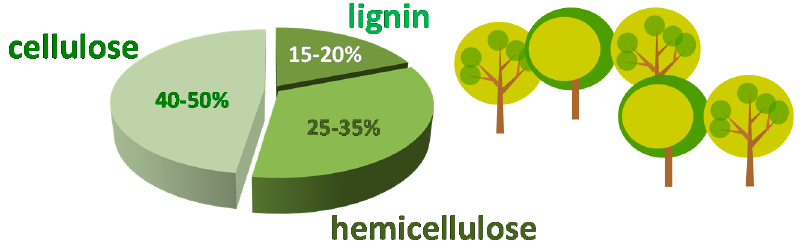
Figure 1. Composition of biomass.